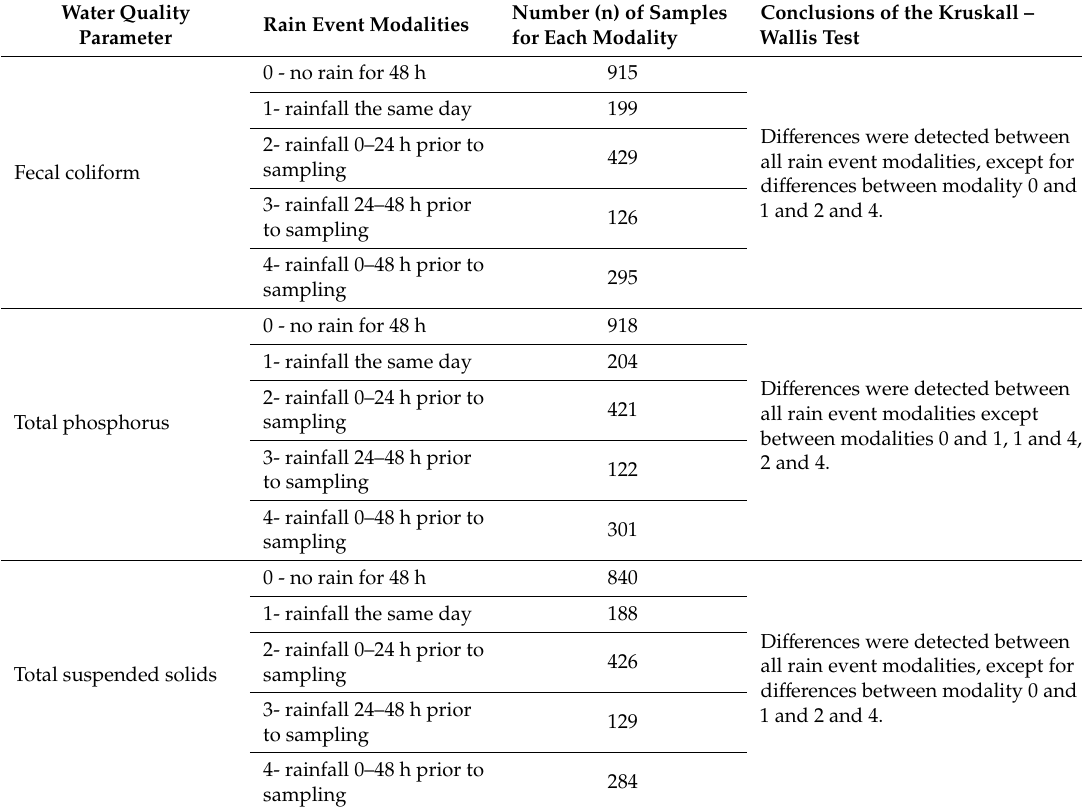
Table 3. Summary of the results of the Kruskall-Wallis test for the three water quality parameters. Water Quality